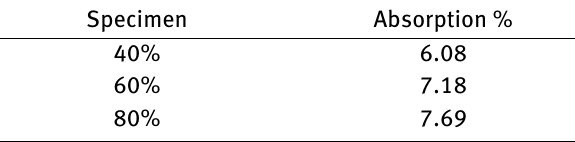
Table 24: Absorption of geopolymer mortar